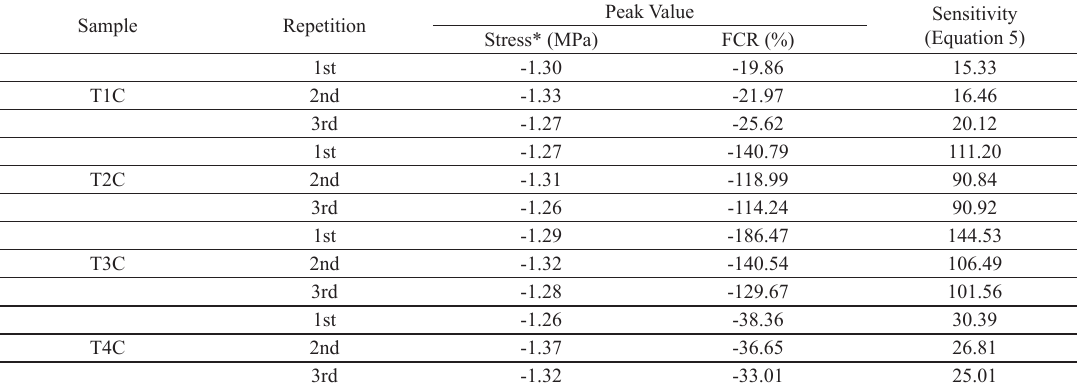
Table 1. Sensitivity of samples based on FCR/Stress relationship.